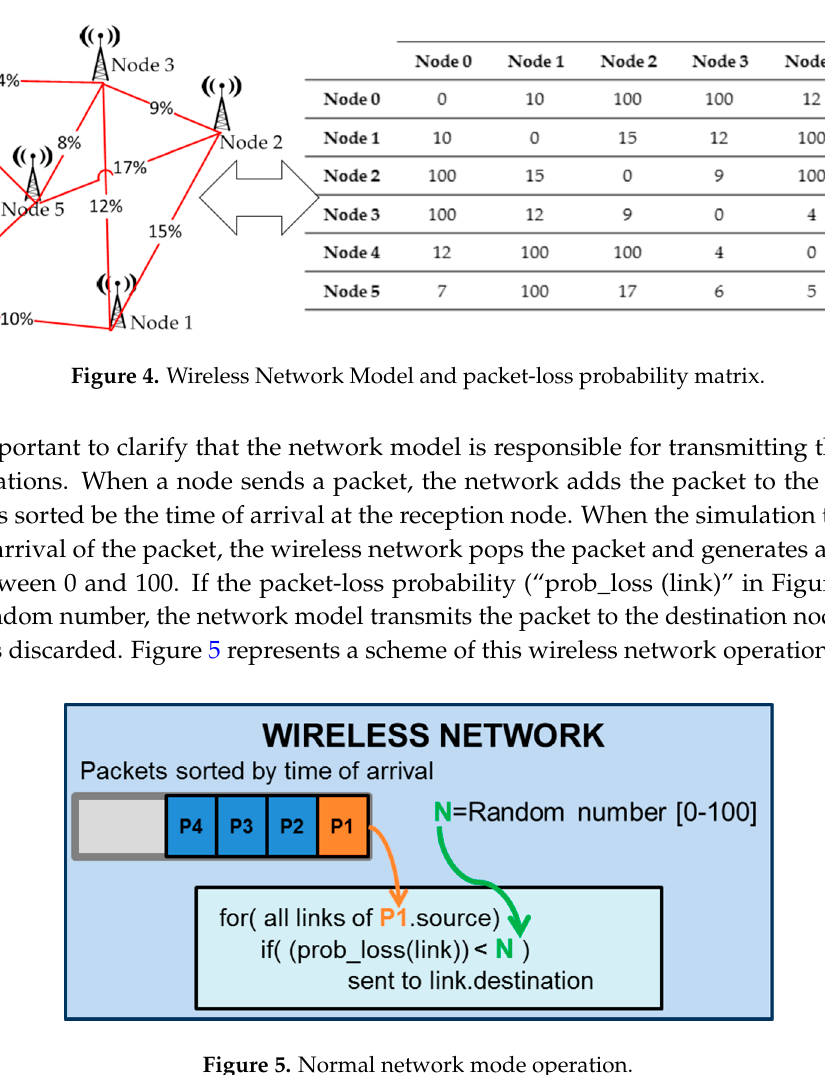
Figure 5. Normal network mode operation.